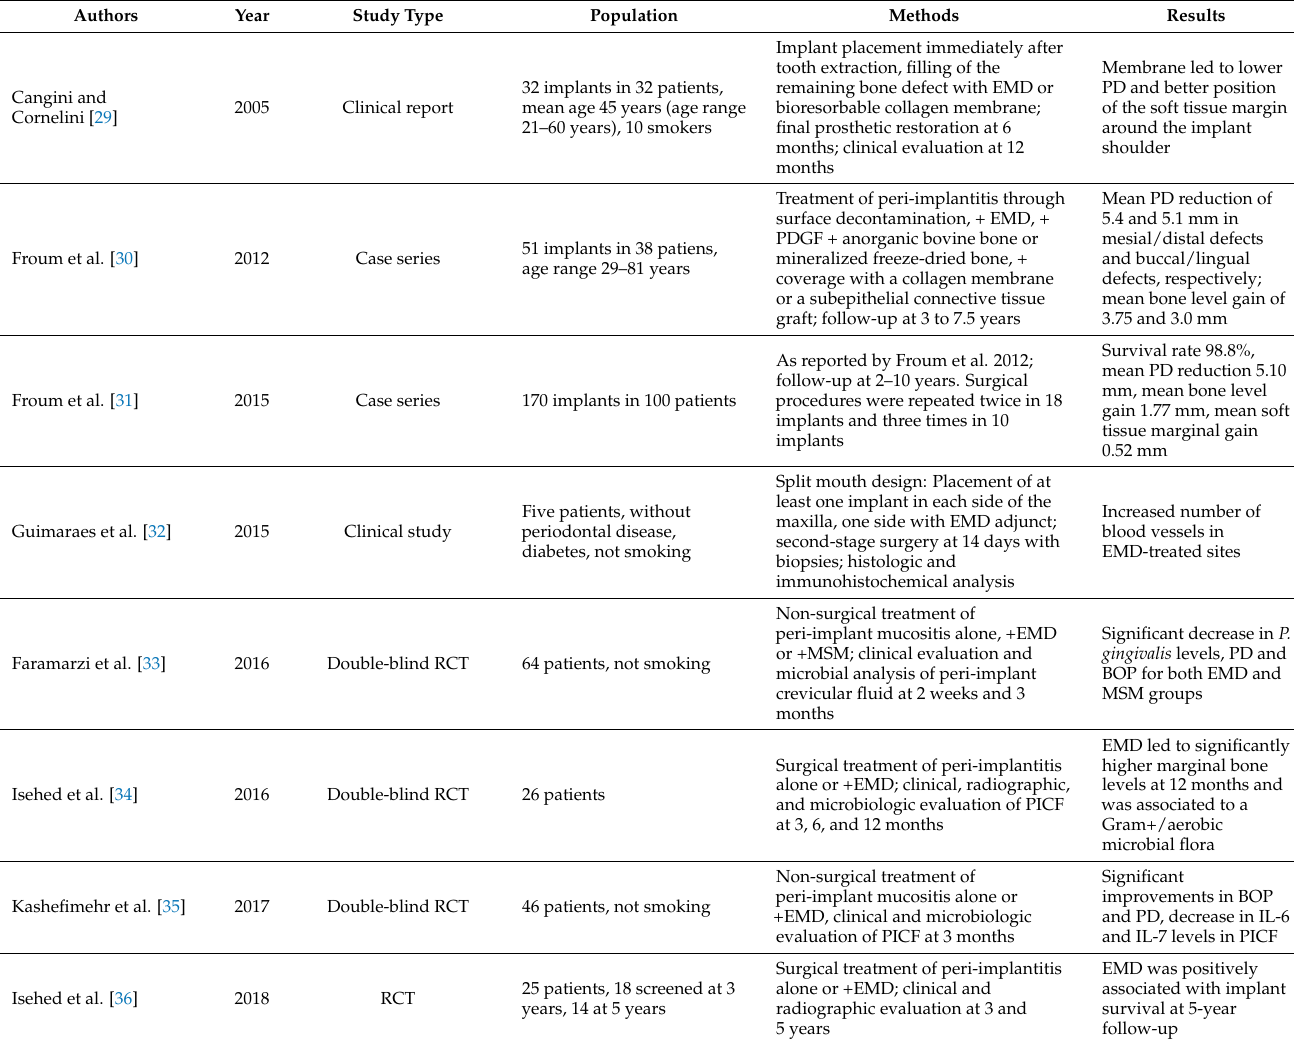
Table 3. Studies evaluating the use of EMD at implant sites in